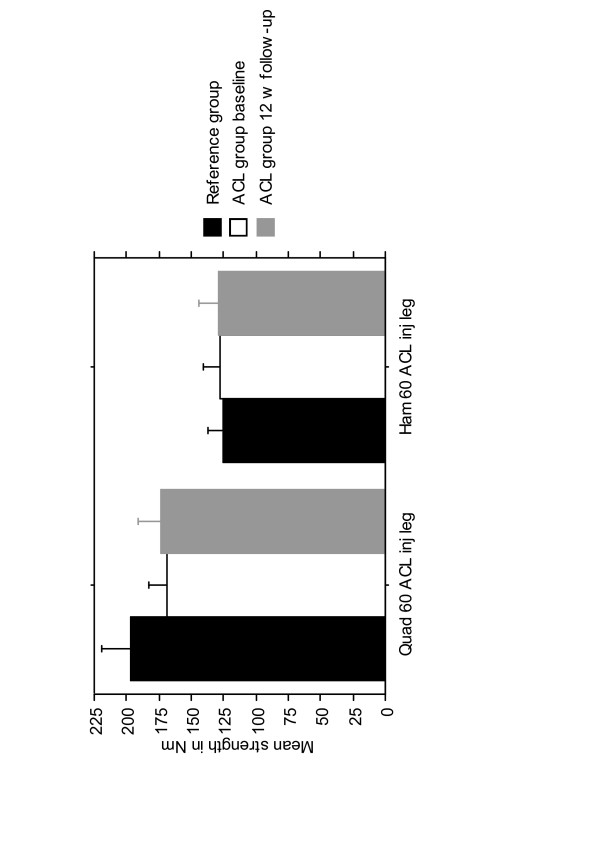
Mean (95% CI) isokinetic thigh strength at 60 degrees/second for the reference group and the ACL group before and after the 12 week training programme.